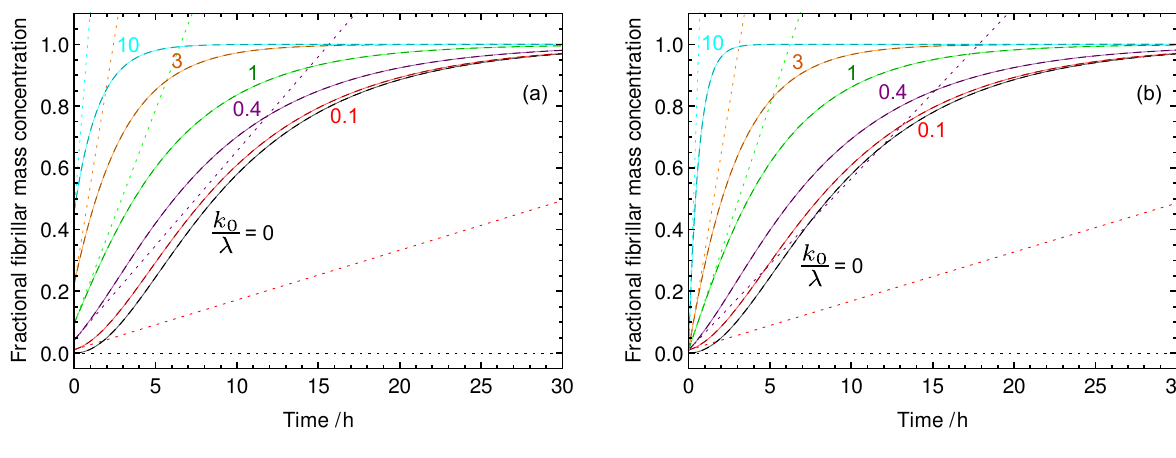
Figure 1. Nucleated polymerisation in the presence of seed material. The thick dashed lines are the exact solution to the rate equations Equation (9); the thin solid lines are calculated from numerical simulations of the master equation Equation (1). The dotted lines = M (0) + 2 k m (0) P (0) t ; a lag-phase exists when the are the initial gradients dM/dt | t =0 + initial gradient is not the maximal gradient. The numbers accompanying each curve are k /λ ; Equation (14) predicts that a lag-phase only exists when this ratio is less than unity. 0 ( a ): Nucleated polymerisation in the presence of an increasing quantity of seed material of a fixed average length (5000 monomers per seed) added at the beginning of the reaction. The seed concentrations given as a fraction of the total concentration of monomer present are right to left): 0, 0.01, 0.04, 0.1, 0.2, 0.5; ( b ): Nucleated polymerisation in the presence of a fixed quantity (1% of total monomer in the system) of seed material of varying average length. The average number of monomer per seed are (right to left): N/A (unseeded), 5000, = 10 µM , n = 3 , 1000, 500, 200, 50. The other parameters for both panels are: m tot c k m n c − 1 n